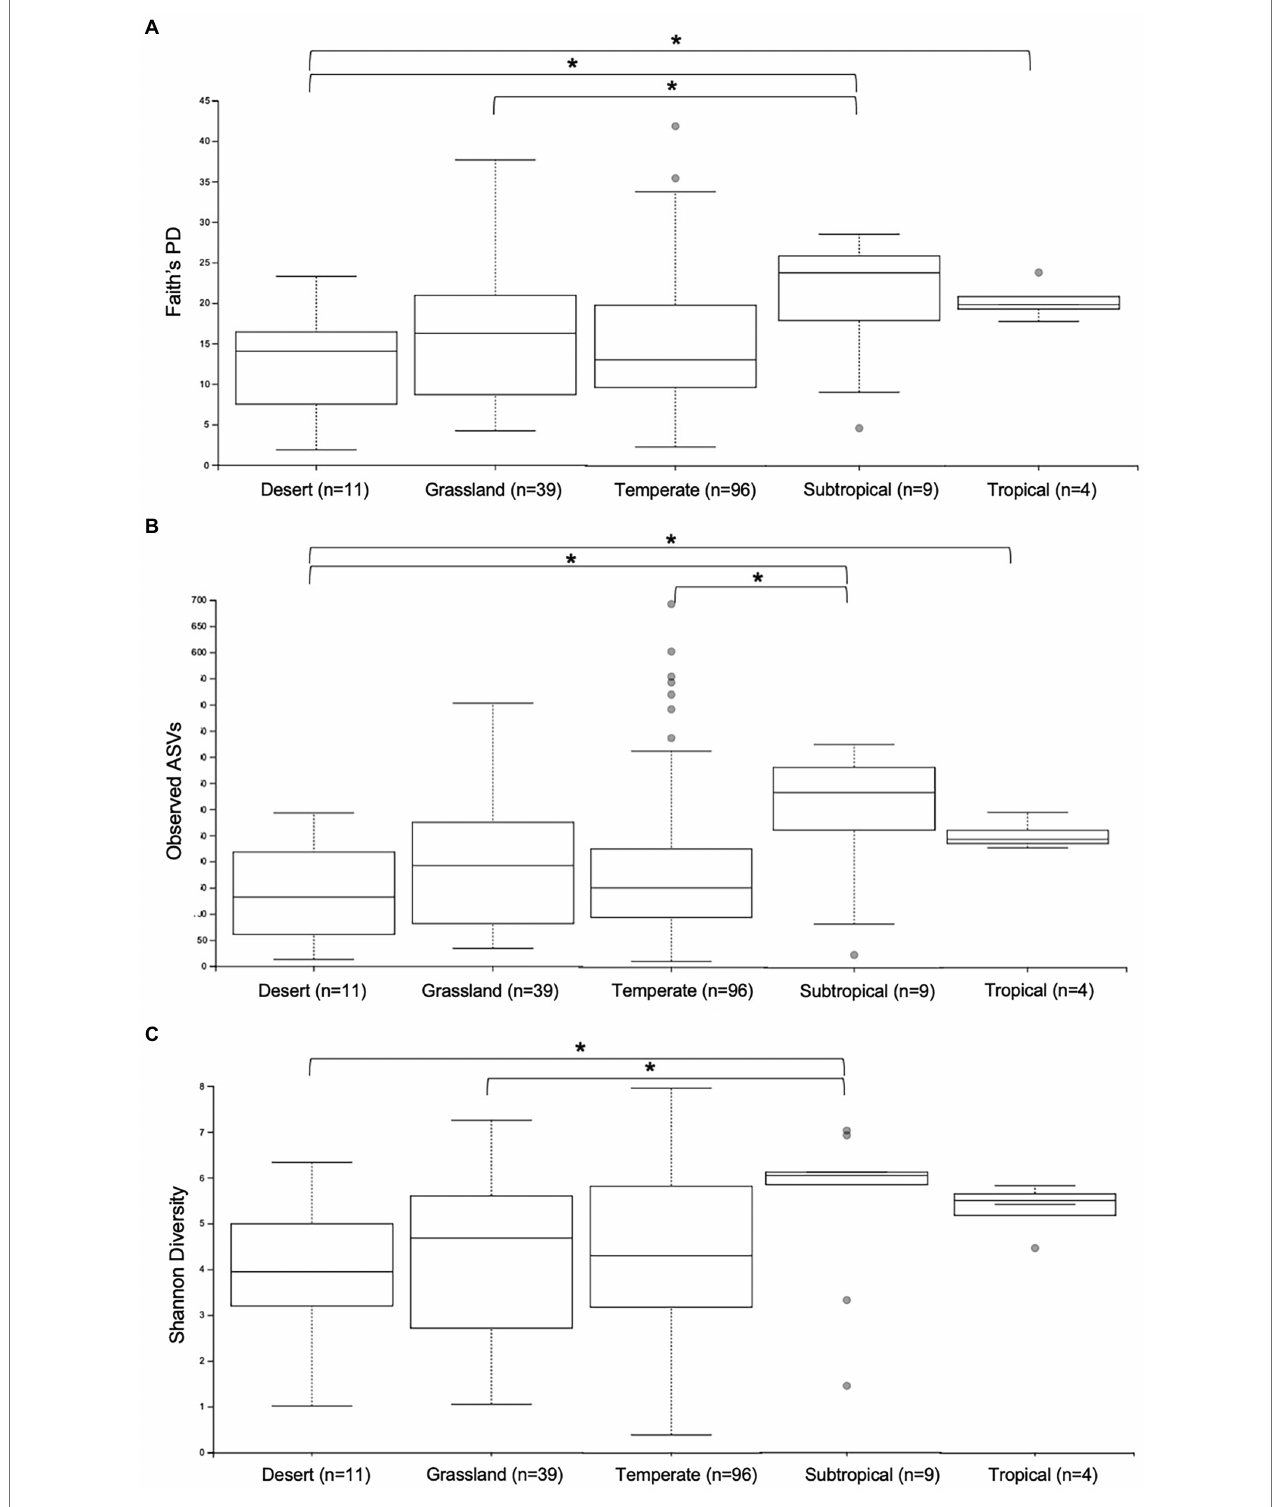
FIGURE 2 | Alpha diversity analyses of gut microbiomes from wild samples collected in different climate regions across Australia. Whisker-box plots depict the following metrics: (A) Faith’s phylogenetic diversity (Faith’s PD); (B) Observed Amplicon Sequence Variants; (C) Shannon’s Diversity index. Horizontal lines indicate median values, upper and lower bounds represent the 25th and 75th percentiles, and top and bottom whiskers indicate maximum and minimum values. Outliers are shown as grey circles. * = 0.01 < p <